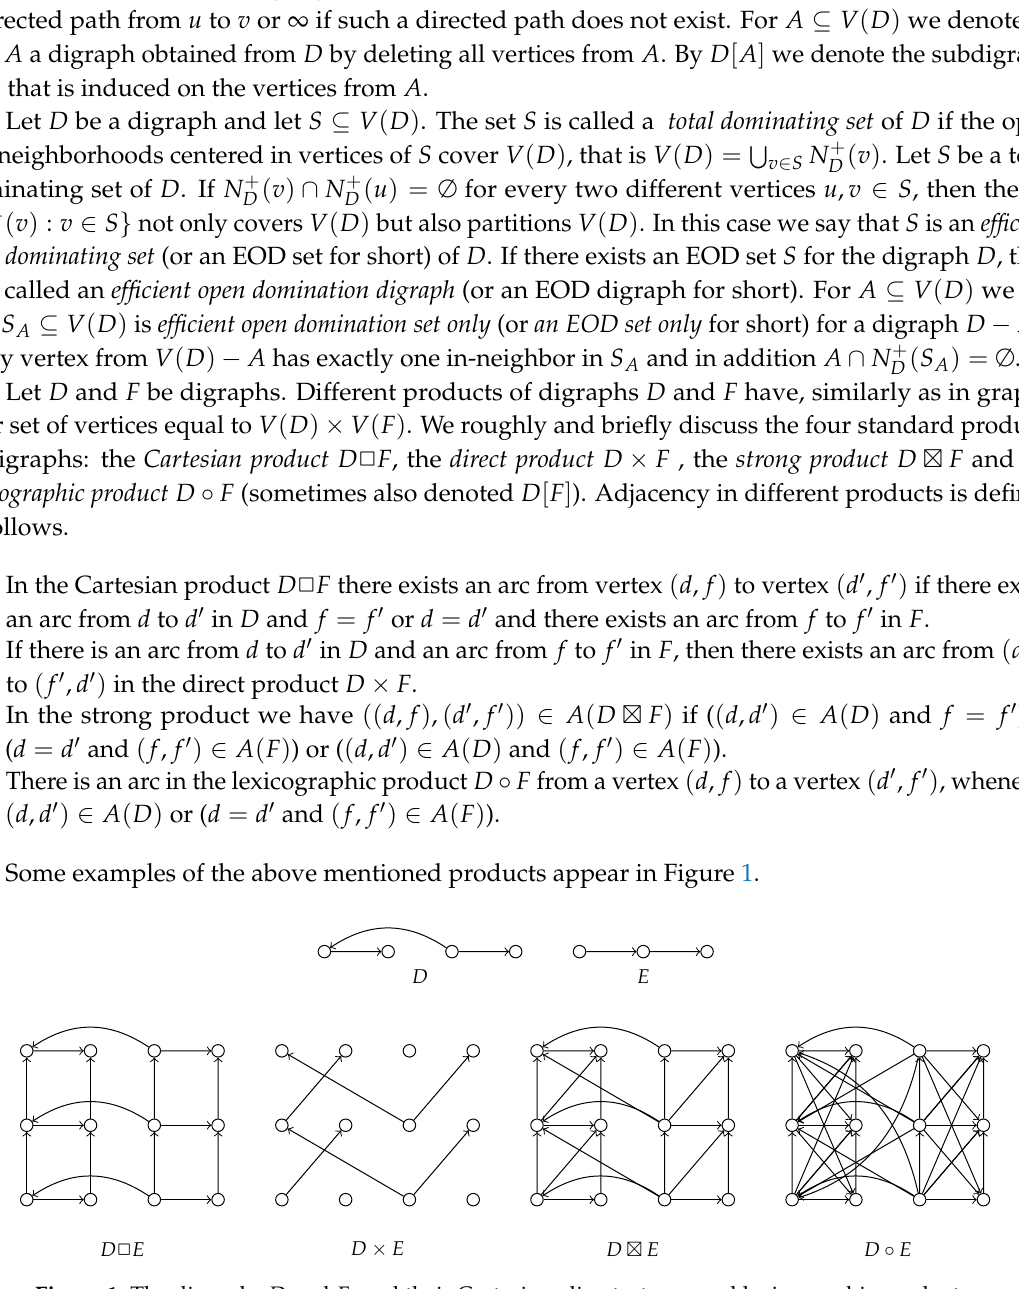
Figure 1. The digraphs D and E , and their Cartesian, direct, strong and lexicographic